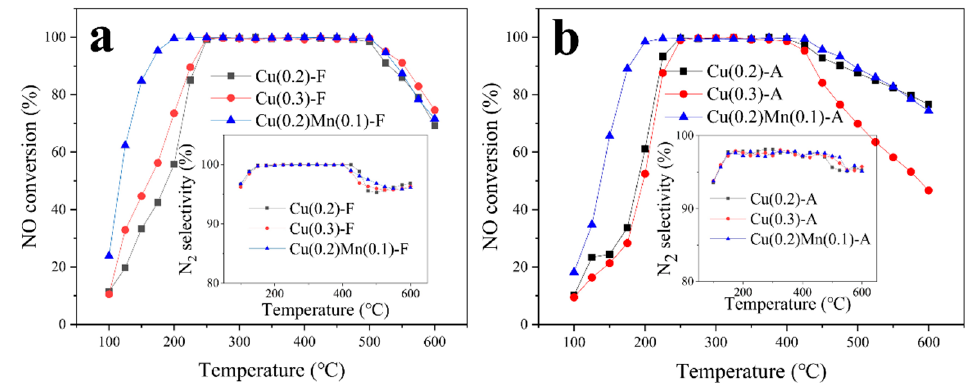
Figure 2. NO conversion with catalysts before ( a ) and after ( b ) hydrothermal aging under a GHSV of 30,000 h − 1 .